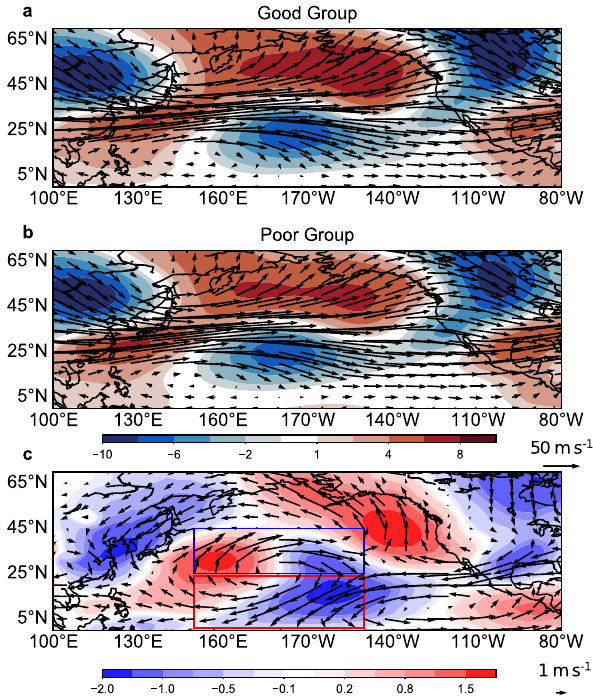
Fig. 9 Climatological winds in the strong and weak MWAF groups and their differences. a , b Climatological winds (vector) at 300-hPa in the strong and weak MWAF groups, respectively. c The differences between the strong and weak MWAF groups. The shading in ( a ) and ( b ) represent the climatological meridional winds, whereas it indicates the difference in the meridional wind between the strong and weak MWAF groups in ( c ). The meridional shear of zonal wind is calculated from the difference of climatological zonal wind over 25°N – 45°N, 150°E – 150°W (blue box) and EQ – 25°N, 150°E – 150°W (red box). The green dots in ( c ) represent areas signi fi cantly above the 90% con fi dence level when comparing two groups with each containing 15